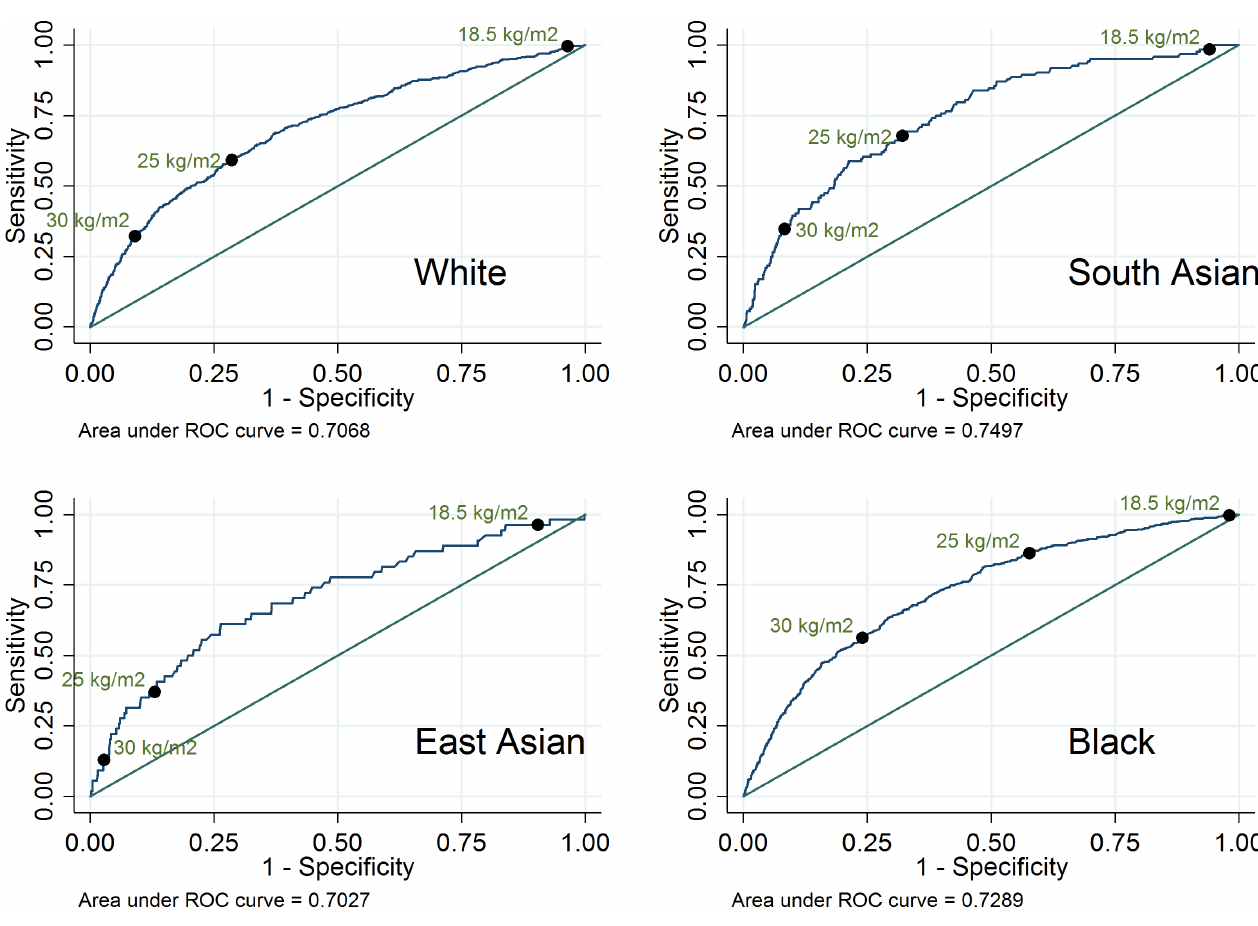
Fig 3. ROC curves for diabetes in pregnancy by BMI, by ethnic